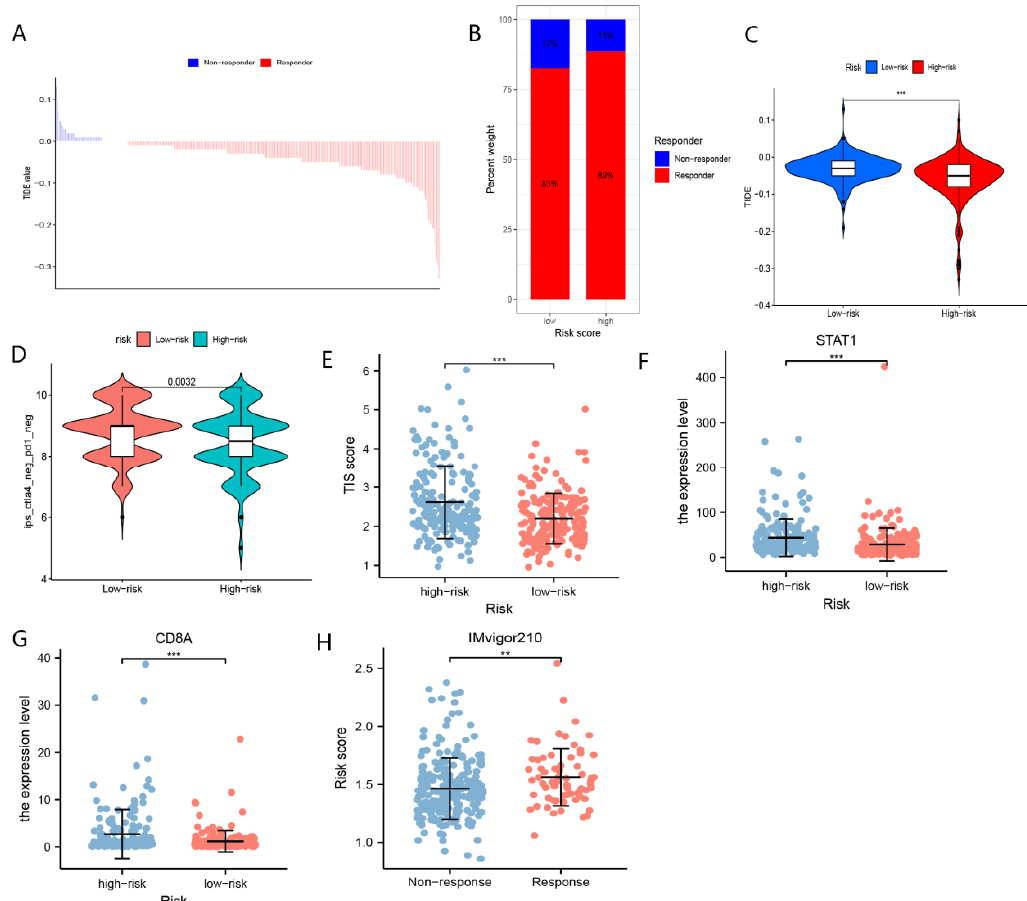
Figure 11. The role of nFRGs in predicting responses to immunotherapy. ( A ) The distribution of TIDE scores in responders and non-responders. ( B ) The proportion of responders and non-responders in the high- and low- risk groups. ( C ) Comparison of TIDE scores in high- and low-risk groups. ( D ) Comparison of IPS scores in high- and low-risk groups. ( E ) Comparison of TIS in the high- and low-risk groups. ( F ) Comparison of expression of STAT1 in the high- and low-risk groups. ( G ) Comparison of expression of CD8A in the high- and low-risk groups. ( H ) Comparison of risk scores in the responders and non-responders to immunotherapy. (**, *** representing p < 0.01 and p < 0.001, respectively).